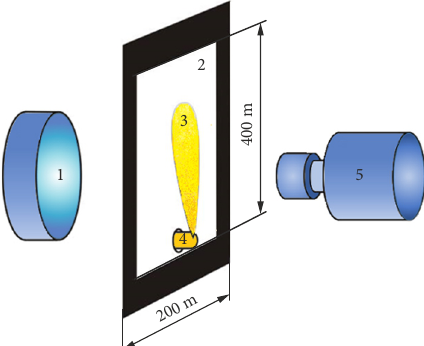
Figure 2. Optical measurement scheme and screen design: